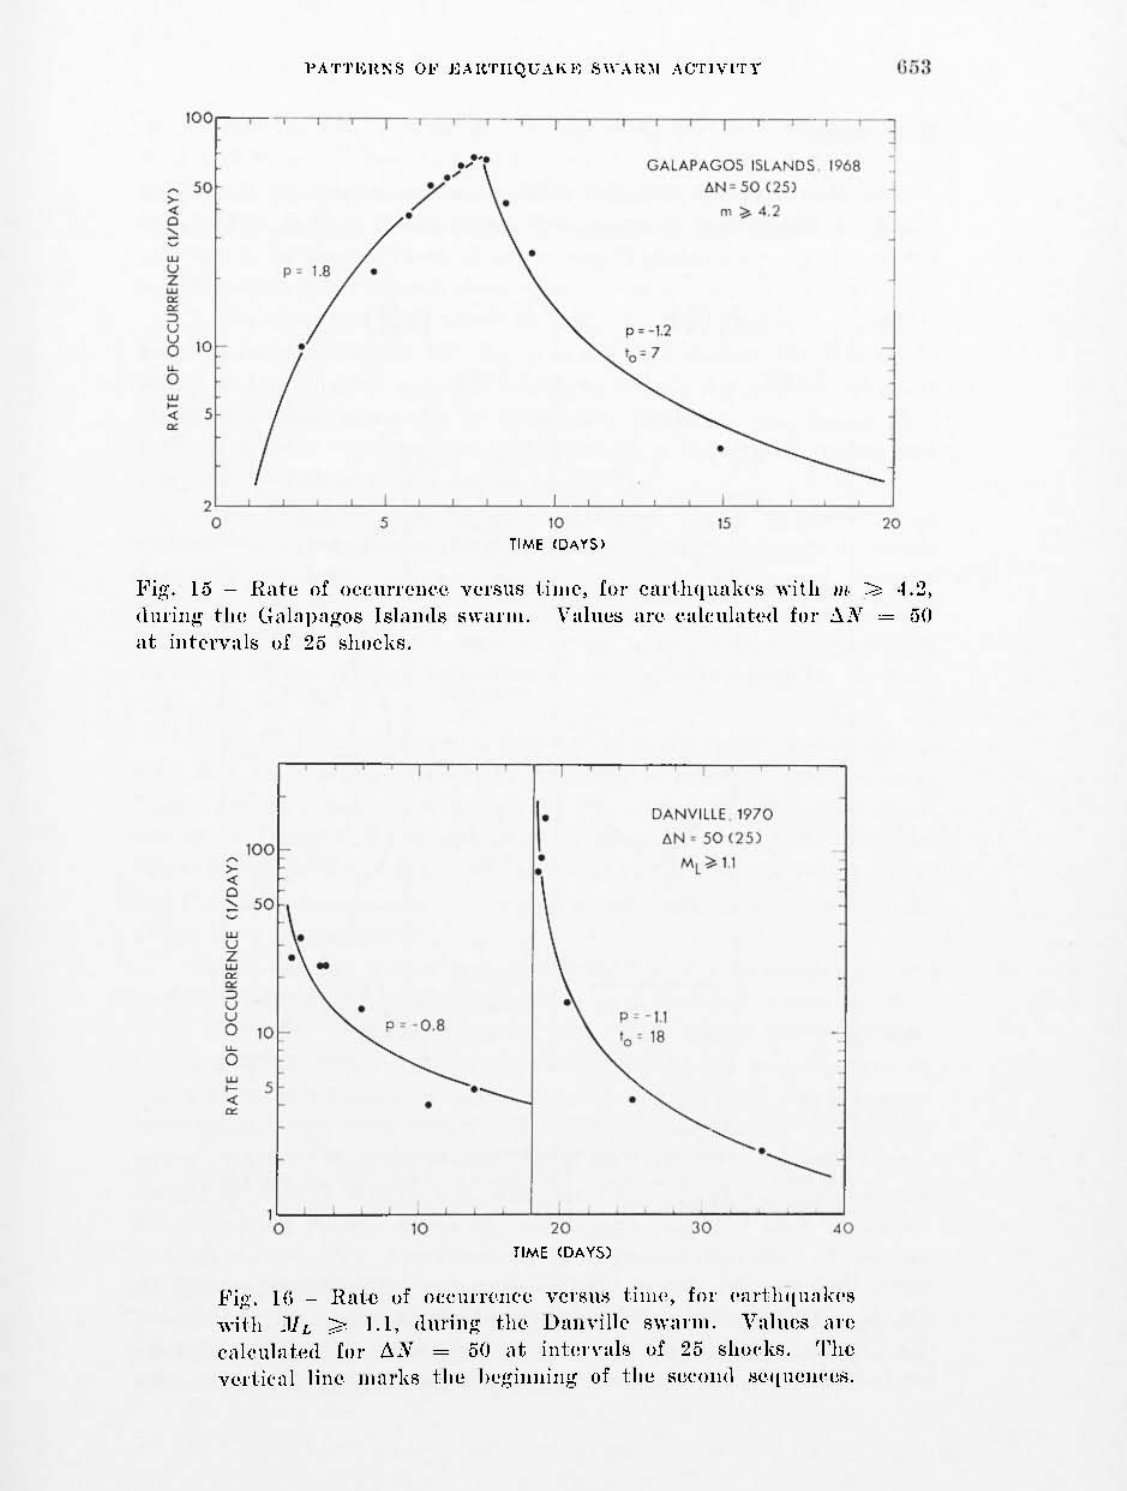
Fig. Hl - Unte uf OITll]"J'('·llec vcr811.~ tilll(', fo!' l'arthllllllkl's wHh JIL > 1.1, dllring thc Dnlldl1e SWlll'nl. Vallle;; are or 25 slw('ks, 'l'hl'. cal('ulat(~d for AN = 50 at intel'l'als v(,l'tieul linI' mu!'ks the hegilillillg" of tlle H()('Olll!